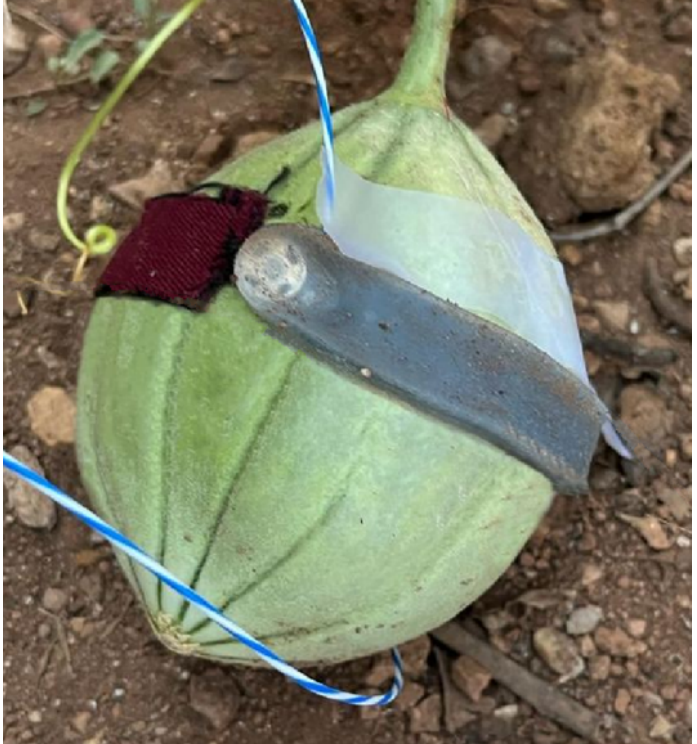
Figure 4. Graphical representation of the sensor positioning on the tested melon in the open